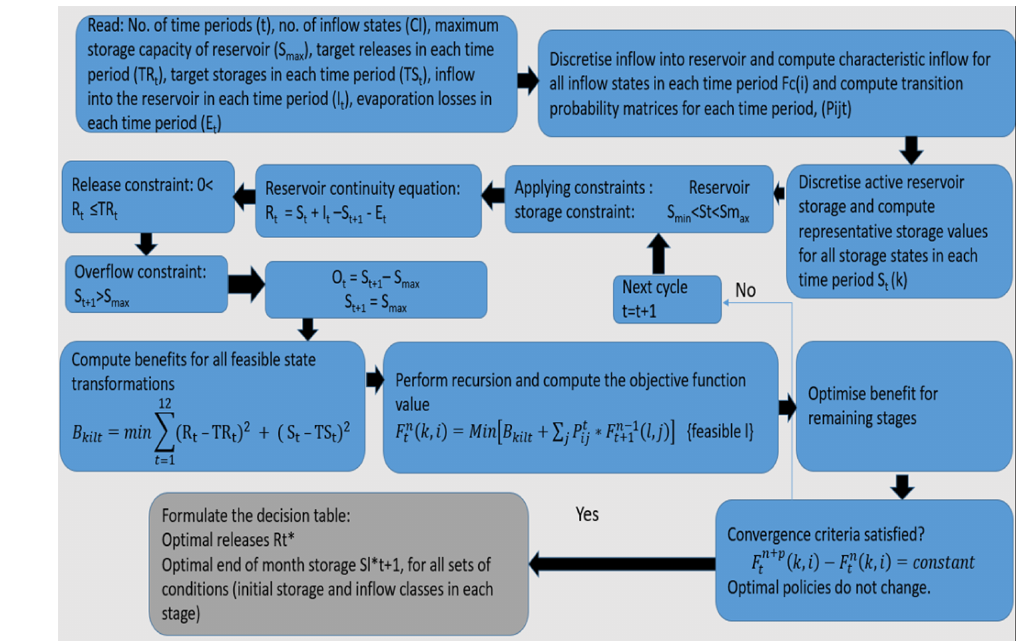
Figure 3. SDP Method Flow chart (Source: Sharma et al., 2016).